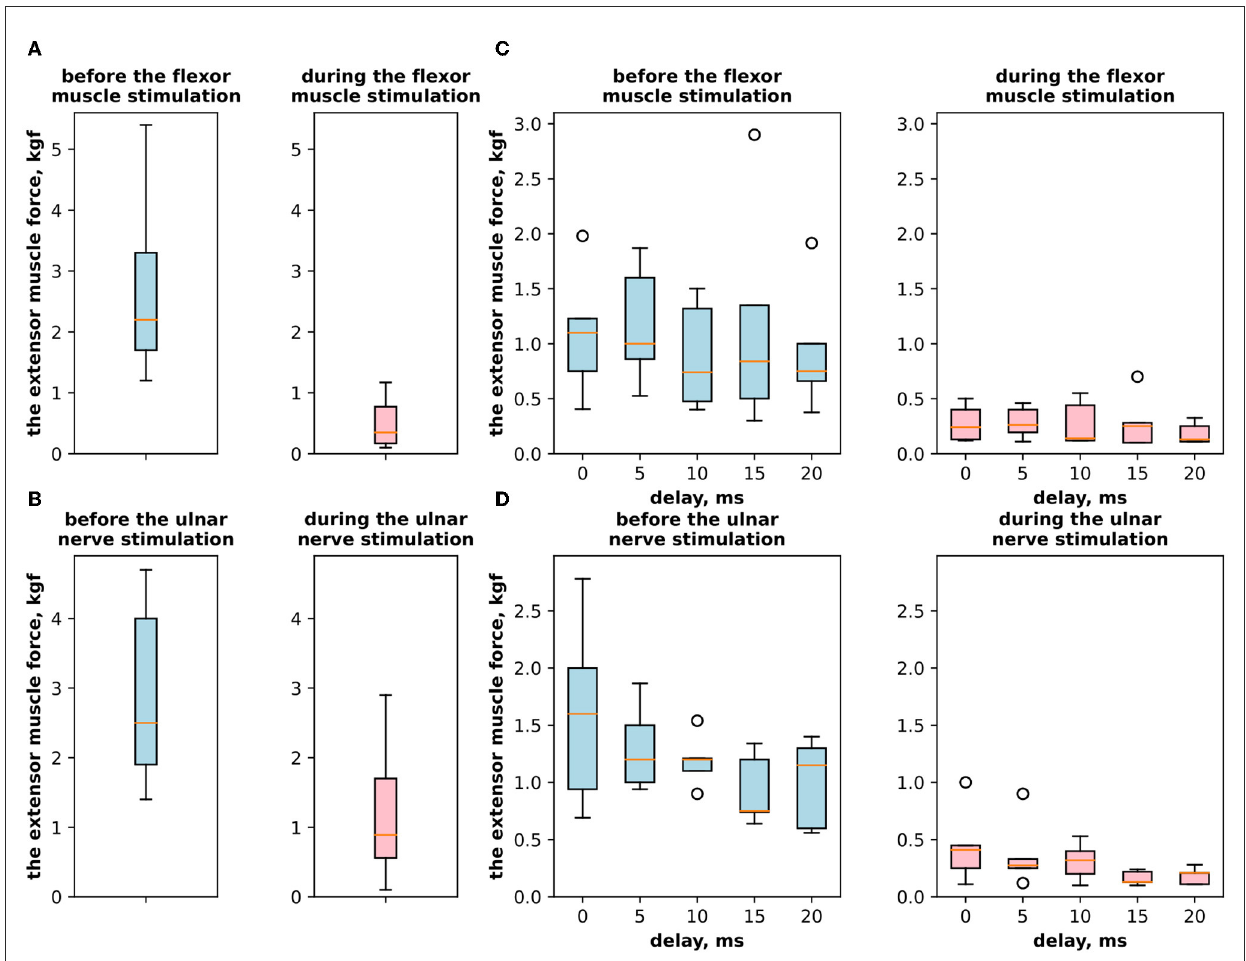
FIGURE3 (A) The extensor muscle force with voluntary activity and during antagonist muscle stimulation (inhibitory effect). (B) The extensor muscle force with voluntary activity and during the ulnar nerve stimulation. (C) The extensor muscle force before antagonist muscle stimulation and during antagonist muscle stimulation (inhibitory effect) with the range of delays. (D) The extensor muscle force before antagonist nerve stimulation and during the ulnar nerve stimulation that innervates the flexor and triggers Ia afferent of the flexor, with the range of delays.